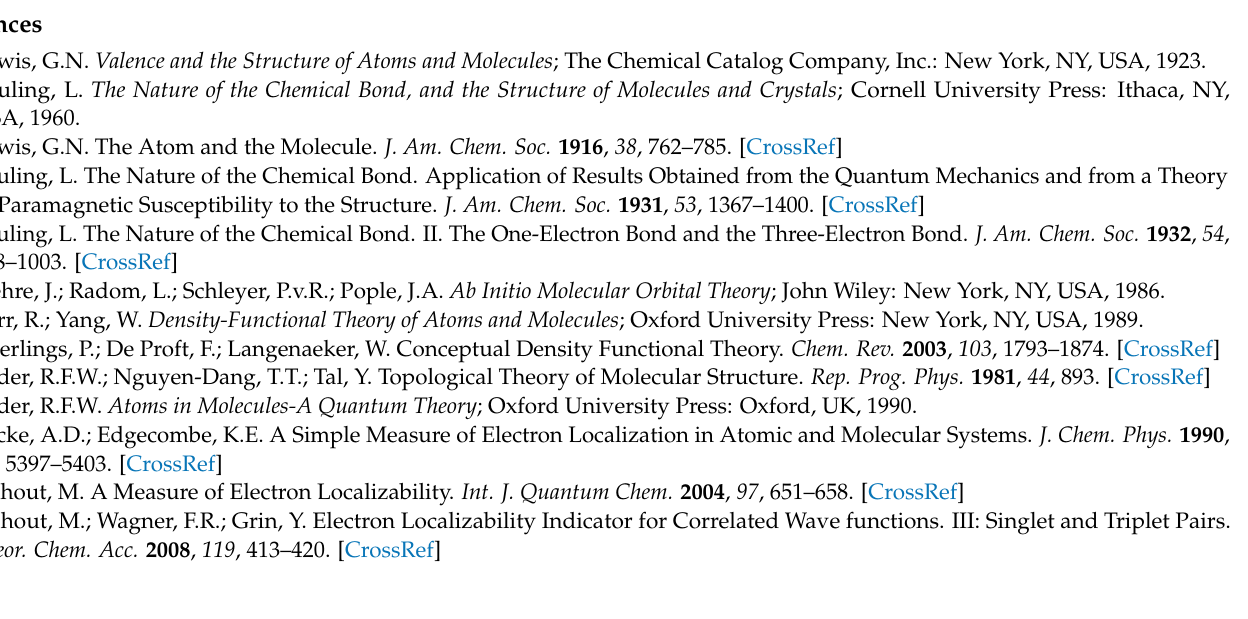
Table S10. Relative electronic energies ( ∆ E, kcal/mol), enthalpies ( ∆ H ◦ , kcal/mol), entropies ( ∆ S ◦ , cal/mol.K) and Gibbs free energies ( ∆ G ◦ , kcal/mol) of activation and reaction for the IM32CA of nitrone-alkene 5; Table S11: Electronic energies, enthalpies, entropies and Gibbs free energies (in a.u) of all species involved in the IM32CA of nitrone-alkene 5; Table S12: Relative electronic energies ( ∆ E, kcal/mol), enthalpies ( ∆ H, kcal/mol), entropies ( ∆ S, cal/mol.K) and Gibbs free energies ( ∆ G, kcal/mol) of activation and reaction for the Thermal decomposition of N-carbamoyl-L-proline; Table S13: Electronic energies, enthalpies, entropies and Gibbs free energies (in a.u) of all species involved in the Thermal decomposition of N-carbamoyl-L-proline; cartesian